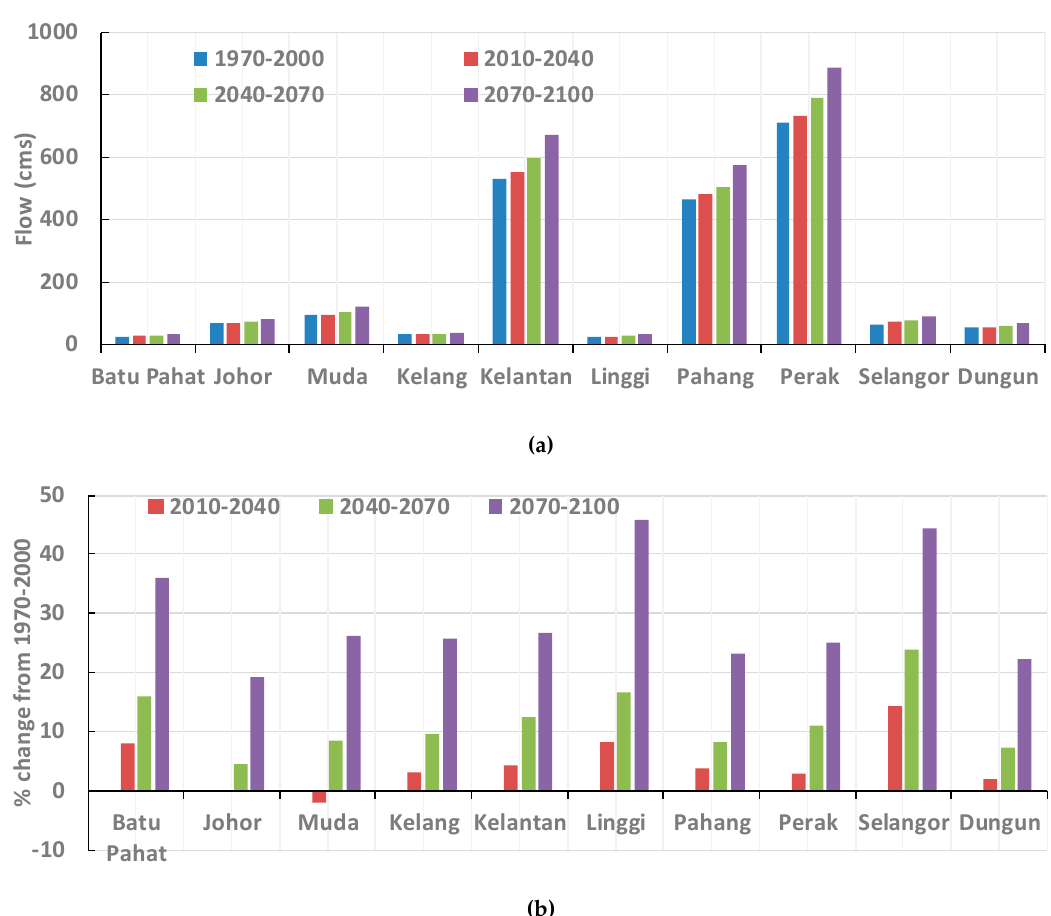
Figure 10. (a ) The 30-year average annual mean flow during the historical period, and through the 21st century; ( b ) the change in the 30-year average of the annual mean flow from the historical period to the early, middle, and end of the 21st century for each of the 10 watersheds of Peninsular